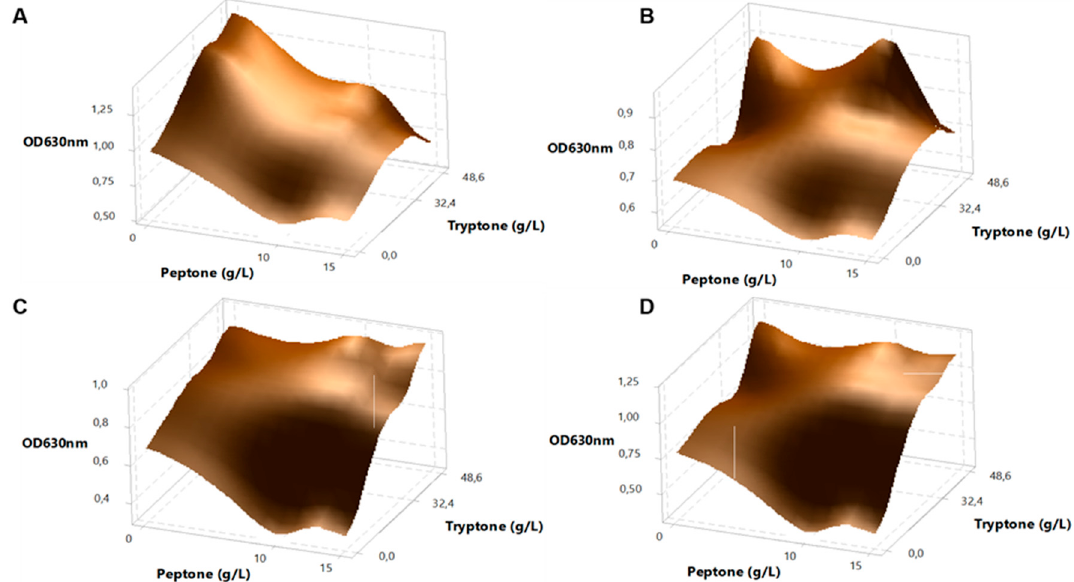
Figure 1. Surface plots of the optimization of protein concentrations in mZMB media. For the four bacteria in the consortium, different tryptone and peptone concentrations were assayed, and maximum optical density (OD 630 ) values were obtained. ( A ) Bi. infantis ; ( B ) Ba. vulgatus ; ( C ) E. coli ; ( D ) L. acidophilus